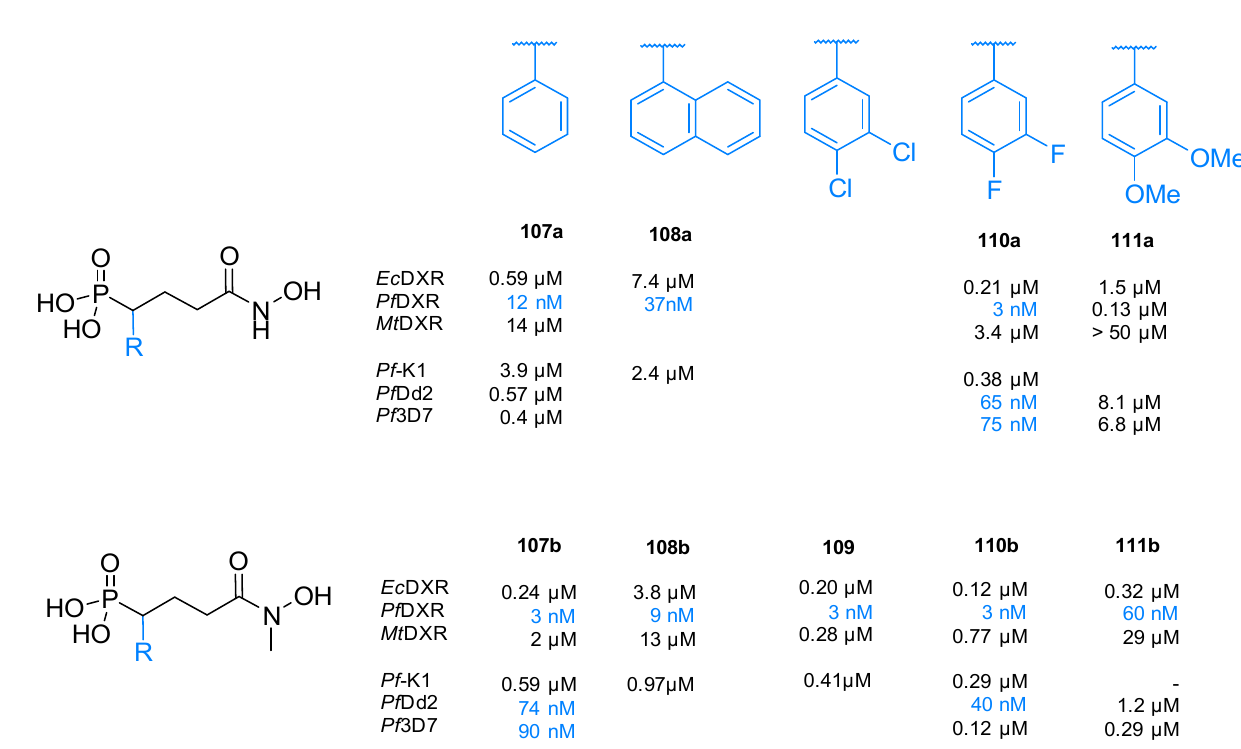
Figure 24. Biological data of α -substituted reverse fosmidomycin analogs ( 105 – 109 ). Interestingly, the in vivo efficacy of the difluorophenyl derivative 110a (application of 80 mg/kg i.p. for 5 days) in a P. berghei ANKA mouse model at day 5 post-infection was almost similar to fosmidomycin. Compounds 110a and 110b reduced the percentage of infected erythrocytes significantly (89% and 78%, respectively), but the effect on mice survival was less pronounced, and no curative antimalarial activity was observed [100]. Moreover, the X-ray crystal structure of Ec DXR in complex with fosmidomycin and Mn 2+ (Figure 25) revealed that fosmidomycin fits perfectly into the closed conformation of the catalytic site, whereas the difluorophenyl ring of 110b would clash with the flexible loop region and therefore binds to the open conformation of the catalytic site.